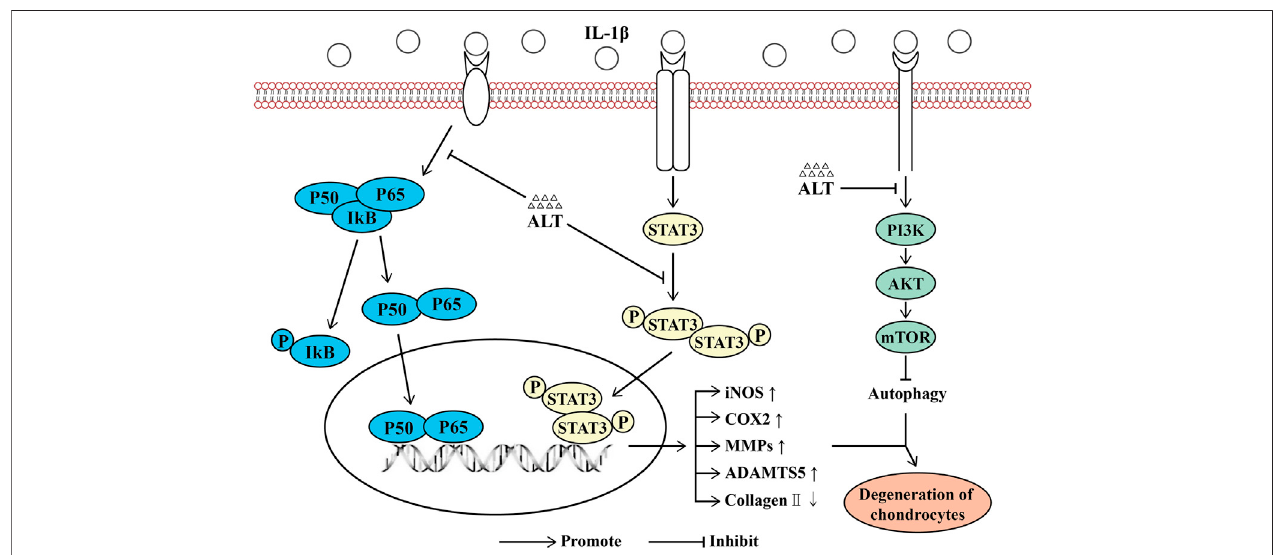
FIGURE 10 | Schematic diagram of the effect of ALT on cartilage degeneration. IL-1 β induces the expression of pro-in fl ammatory factors, including iNOS, COX2, MMPsandADAMTS5.IL-1 β stimulatesthedegradationofCollagenIIandtheimpairmentofautophagy.Furthermore,IL-1 β functionsbyactivatingthePI3K/AKT/mTOR, NF- κ B signaling pathways, phosphorylating and translocating STAT3. As shown in the fi gure, the levels of P-PI3K, P-AKT, P-mTOR, P-IKB, P-P65, P-STAT3 and the translocation of P65 and STAT3 are increasing. However, ALT can attenuate these